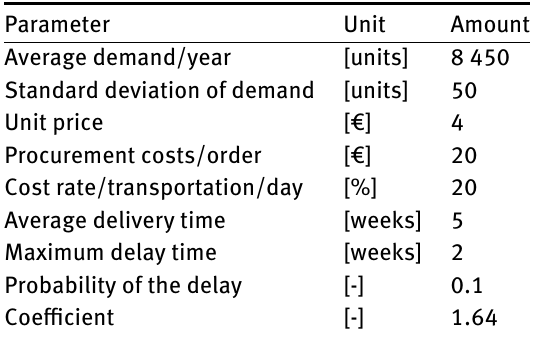
Table 1: The input data of the